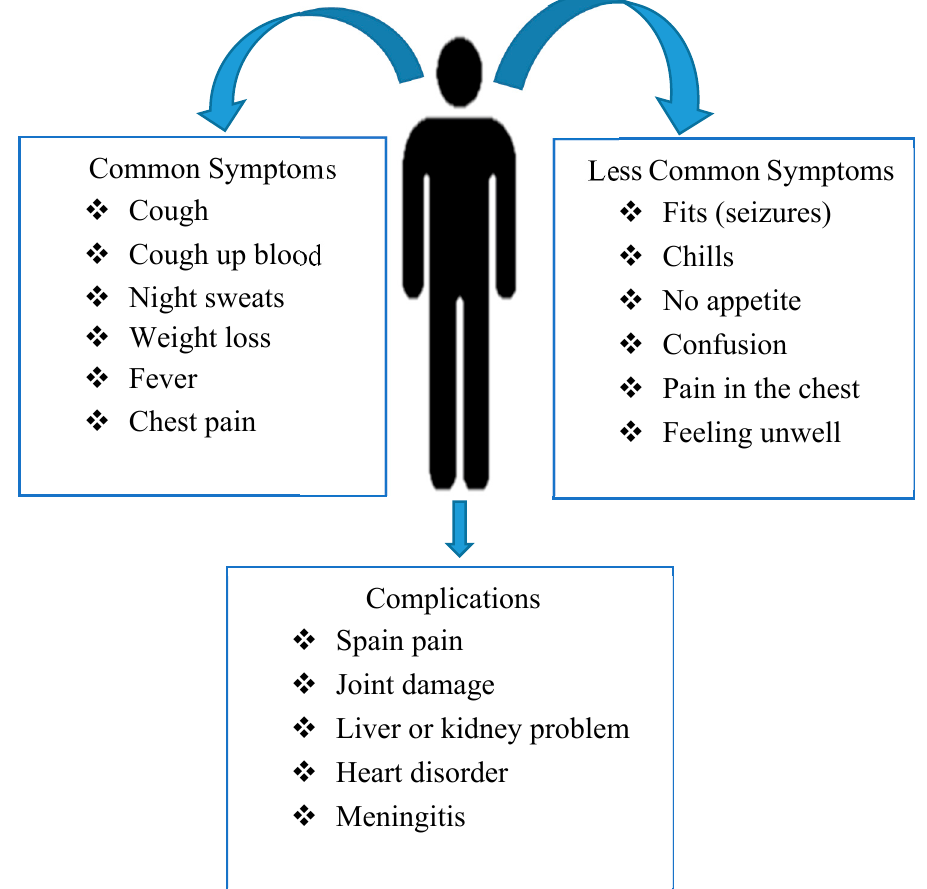
Figure 1. Typical symptoms of TB.